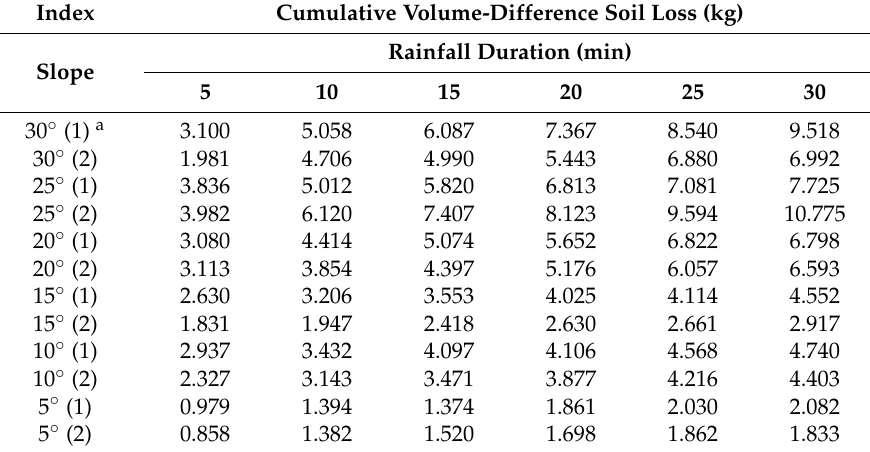
Table 2. Estimates of soil loss using laser-scanned